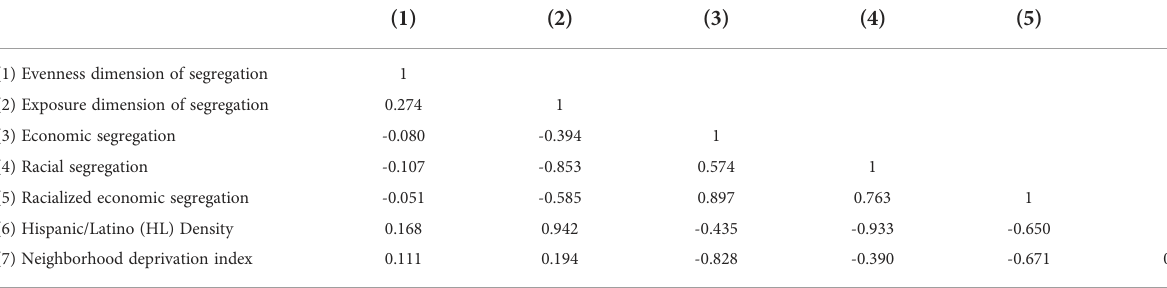
TABLE 3 Correlations between neighborhood segregation measures in analytical